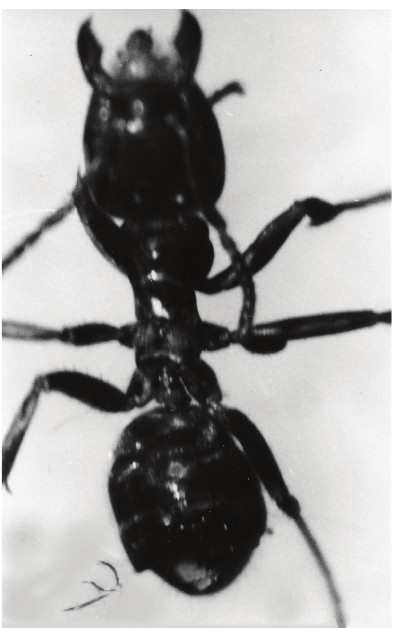
Figure 23: Three dauer juveniles of Formicodiplogaster myrmenema adjacent to a worker of Azteca alpha in Dominican